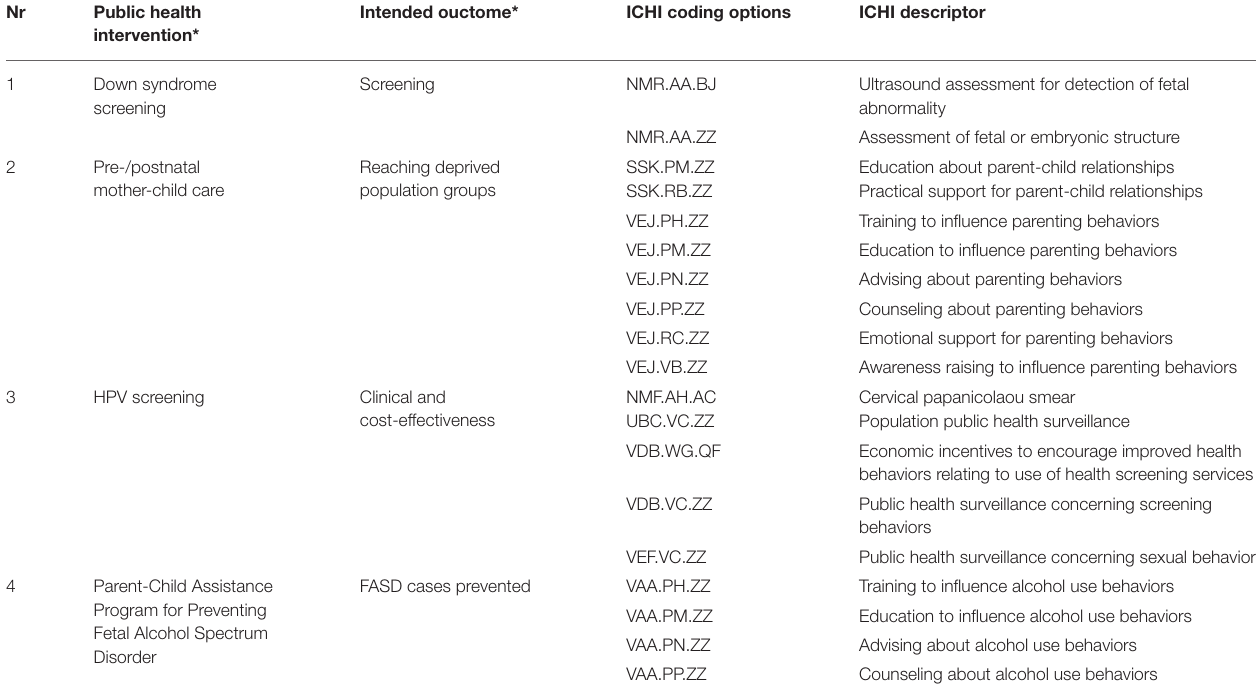
TABLE 3 | Examples of ICHI coding